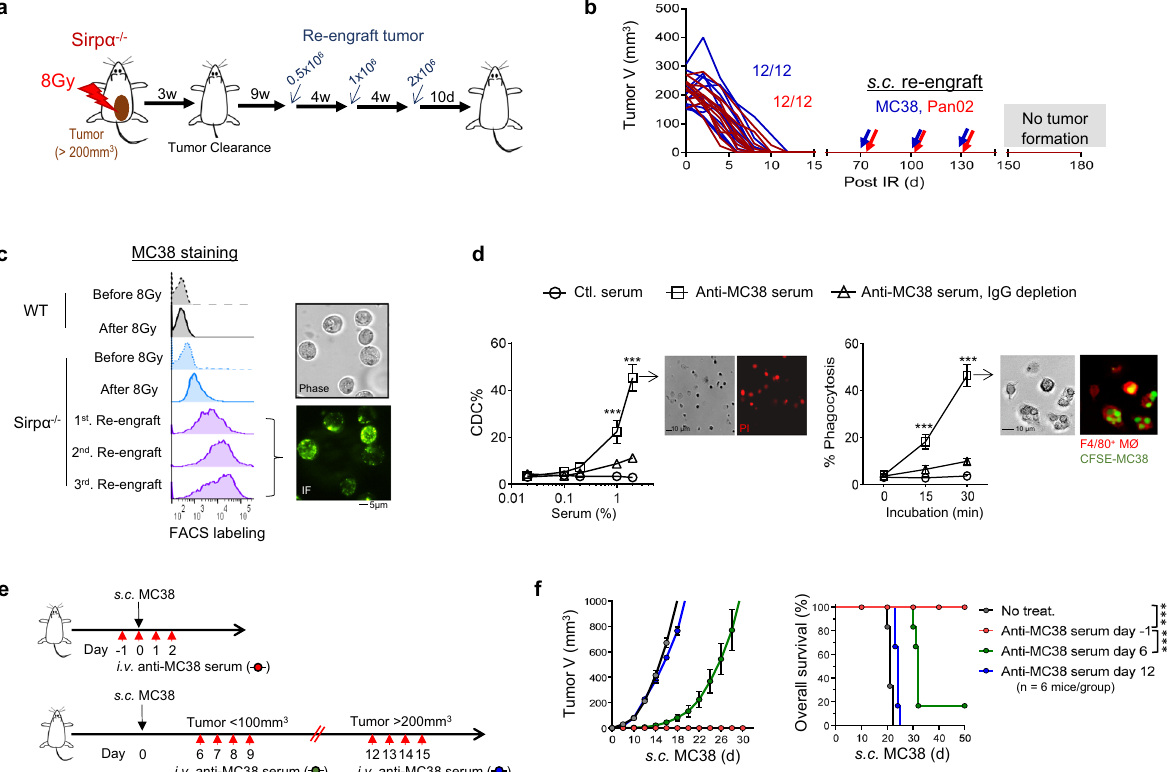
Fig. 8 Long-lasting humoral antitumor immunity in tumor-eradicated Sirp α − / − mice. a Experimental scheme. After eradicating MC38 or Pan02 tumors (3-weeks post-RT), Sirp α − / − mice were re-challenged with three rounds of dose-escalating inoculums of the same cancer cells. b Tumor size post-RT and MC38 or Pan02 re-engraftment. Data are representative of three independent experiments (4 mice/group in each experiment). n = 12 mice in each